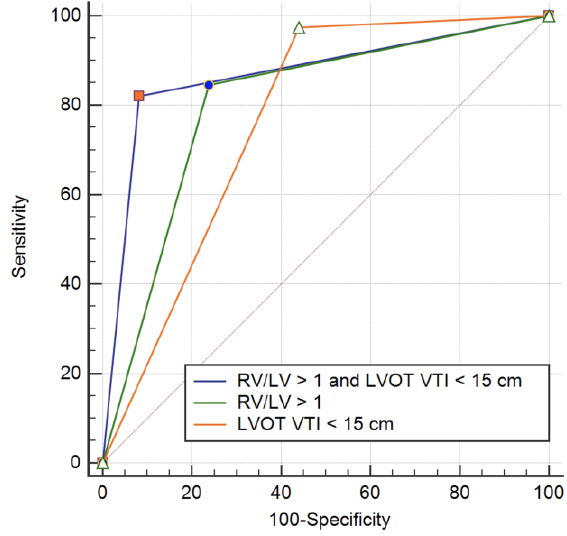
Figure 5 . ROC curves for adverse events prediction in intermediate-high risk PE . Figure 5. ROC curves for adverse events prediction in intermediate-high risk